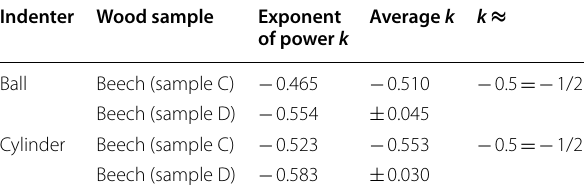
Table 3 Experimental values of the exponents of power k for the diameters D of